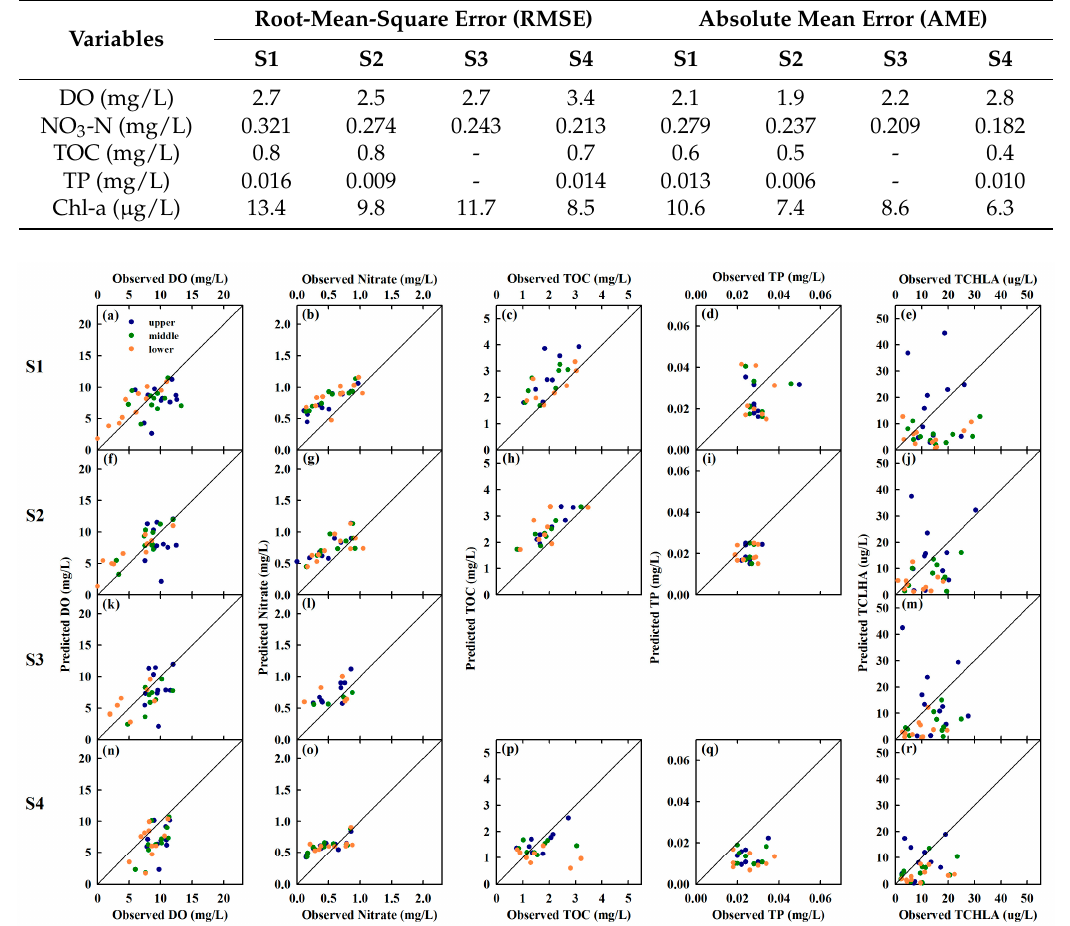
Figure 5. Comparison of predicted and observed dissolved oxygen (DO), nitrate, total organic carbon (TOC), total phosphorus (TP), and Chl-a concentrations at S1 ( a – e ), S2 ( f – j ), S3 ( k – m ), and S4 ( n – r ). The quantitative model errors calculated are given in Table 4.